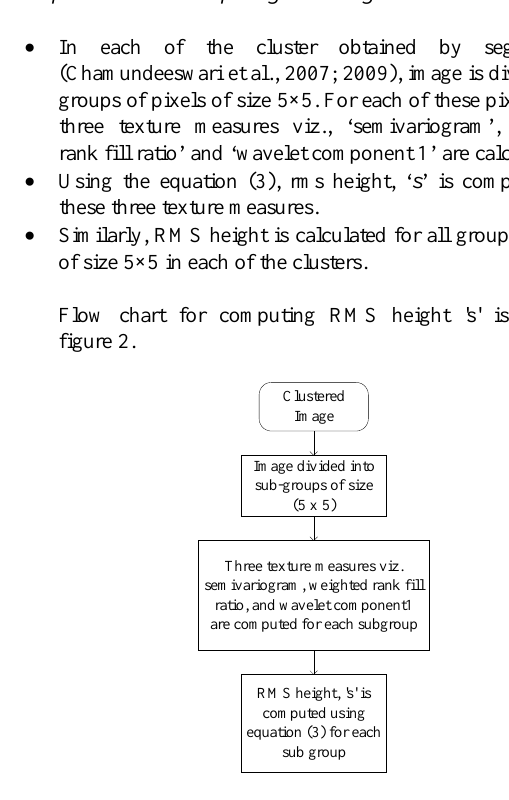
Critical analysis to label the various